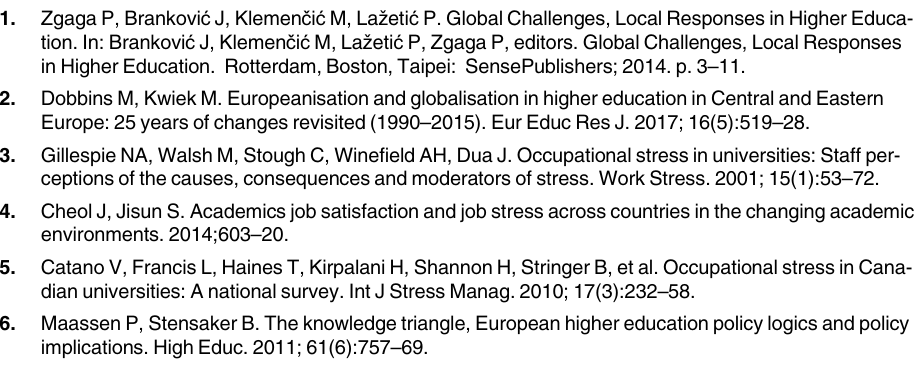
S1 Table. Descriptive statistics of IV, DV and moderators. S2 Table. Participants’ socio-demographic characteristics. S3 Table. Basic and moderated models and the range of moderations (Johnson-Neyman